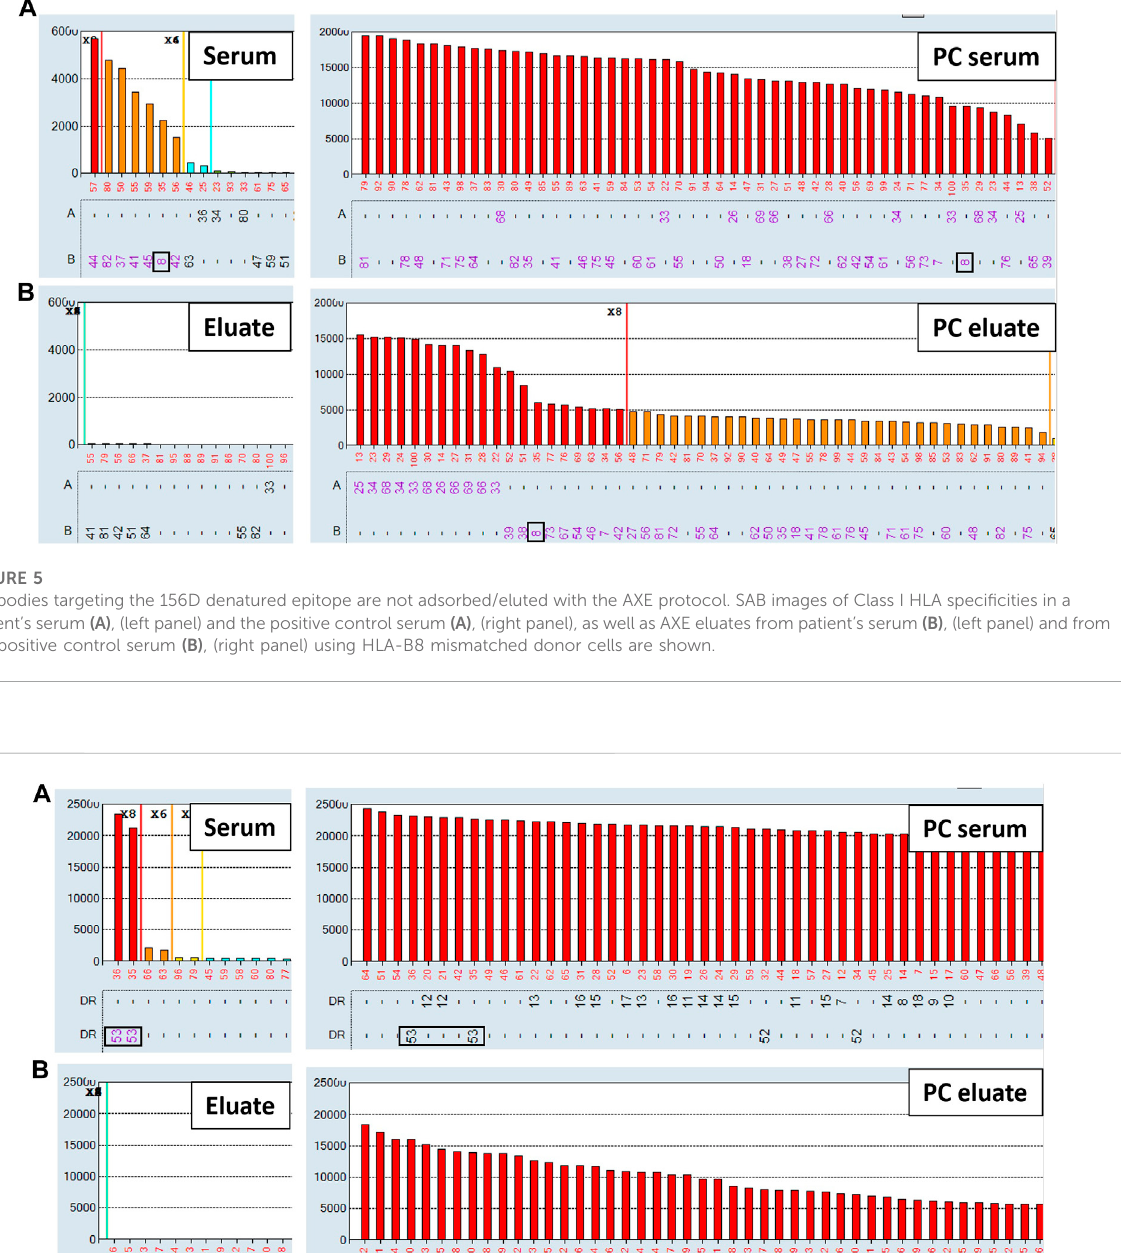
FIGURE 6 Spurious antibodies targeting HLA-DR53 expressing SABs are not adsorbed/eluted with the AXE protocol. SAB images of Class II HLA speci fi cities in a patient ’ s serum (A) , (left panel) and the positive control serum (A) , (right panel), as well as AXE eluates from patient ’ s serum (B) , (left panel) and from the positive control serum (B) , (right panel) using HLA-DR53 mismatched donor cells are